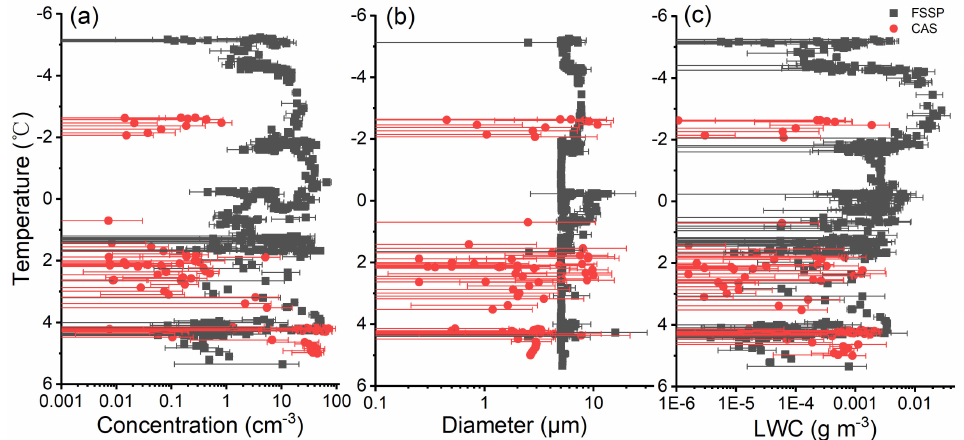
Figure 3. Based on the DMT-CAS data (red circles: 2–45 µ m) FF and the PMS-FSSP data (black squares: 2–45 µ m) FF, the variation in ( a ) the cloud droplet concentration, ( b ) average diameter, and ( c ) liquid water content (LWC). Standard deviations represent uncertainties in the probe